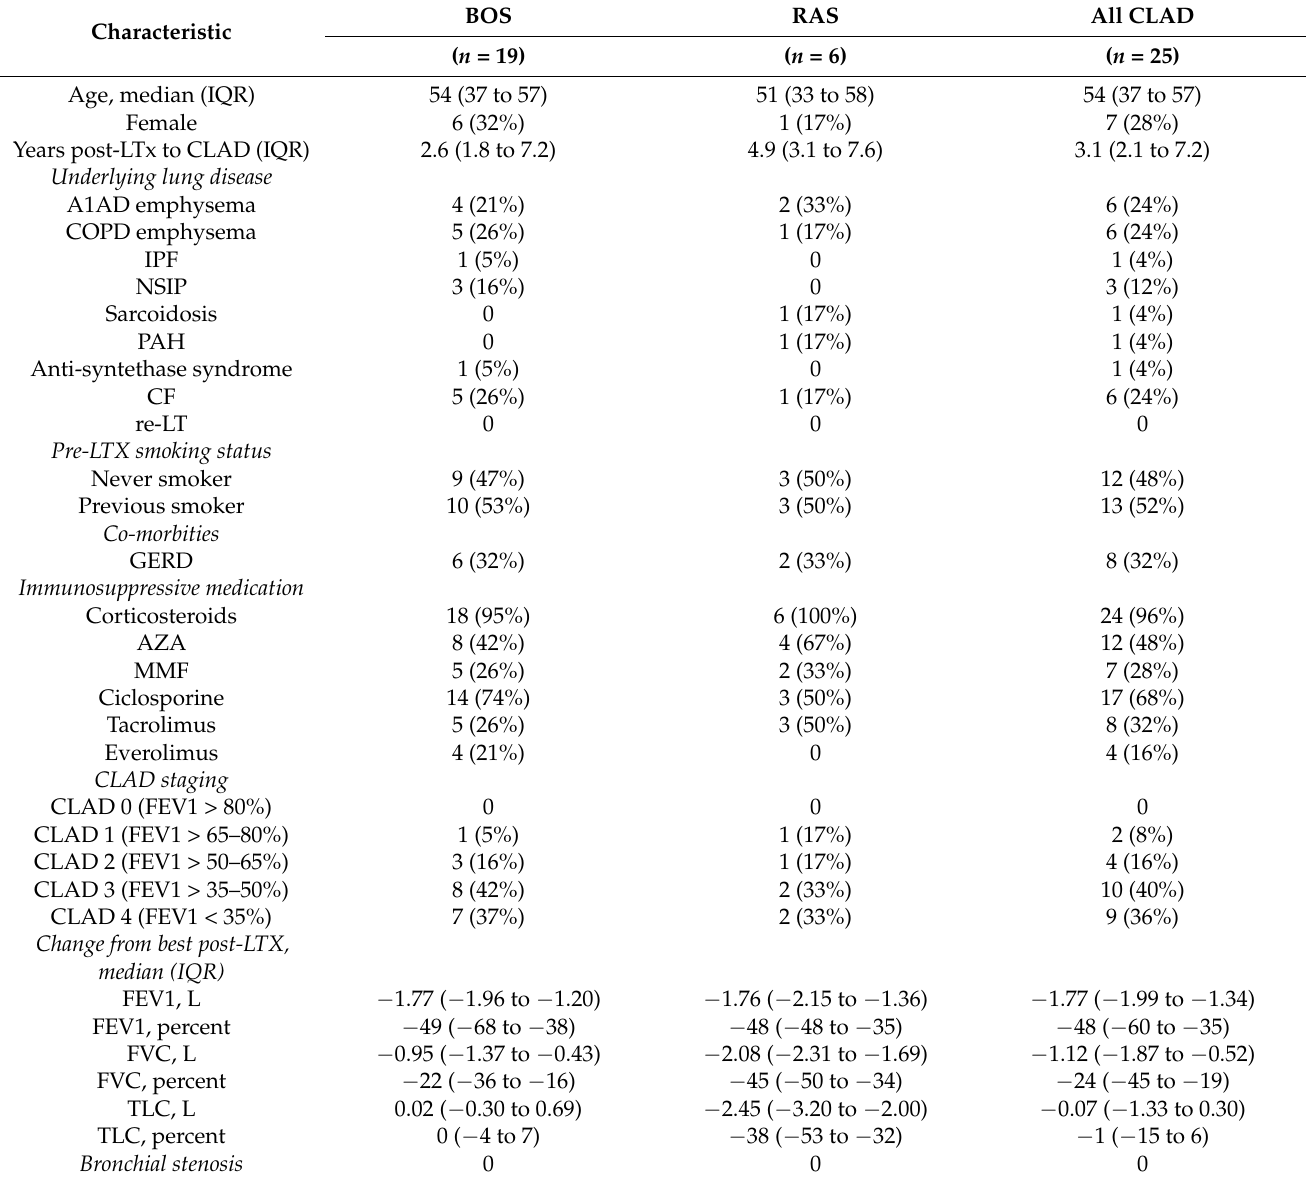
Table 1. CLAD-Patient